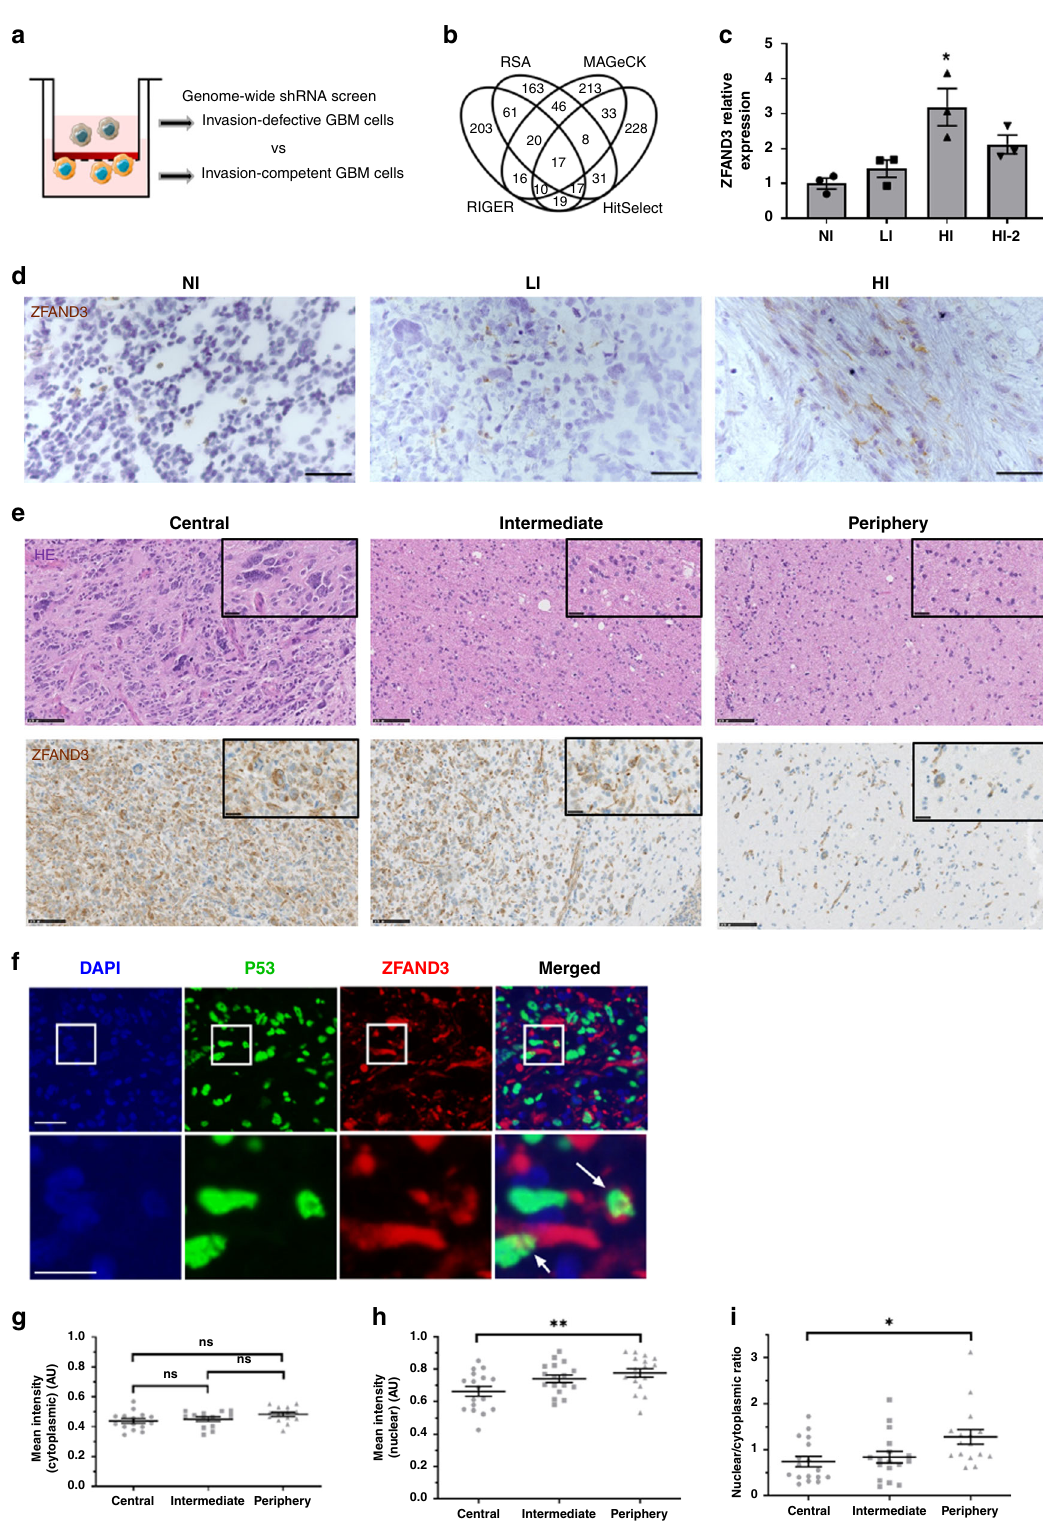
performed colabeling for Iba1 (microglia marker) and NeuN (neuronal marker). We observed some colocalization with Iba1, but not with NeuN, both in clinical samples (Supplementary Fig. 3e) and in xenografts (Supplementary Fig. 3f), indicating that ZFAND3 is expressed by a subpopulation of microglial cells. The majority of staining was found in the tumor area rather than in the neuropil (Supplementary Fig. 3f lower panel). In conclusion,